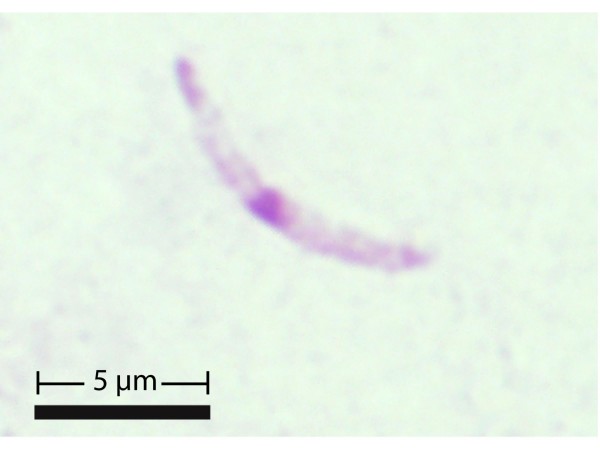
Giemsa-stained sporozoite of Plasmodium spp. from the salivary glands of Coquillettidia aurites. Note a prominent centrally located nucleus. (Scale bar = 5 μm).